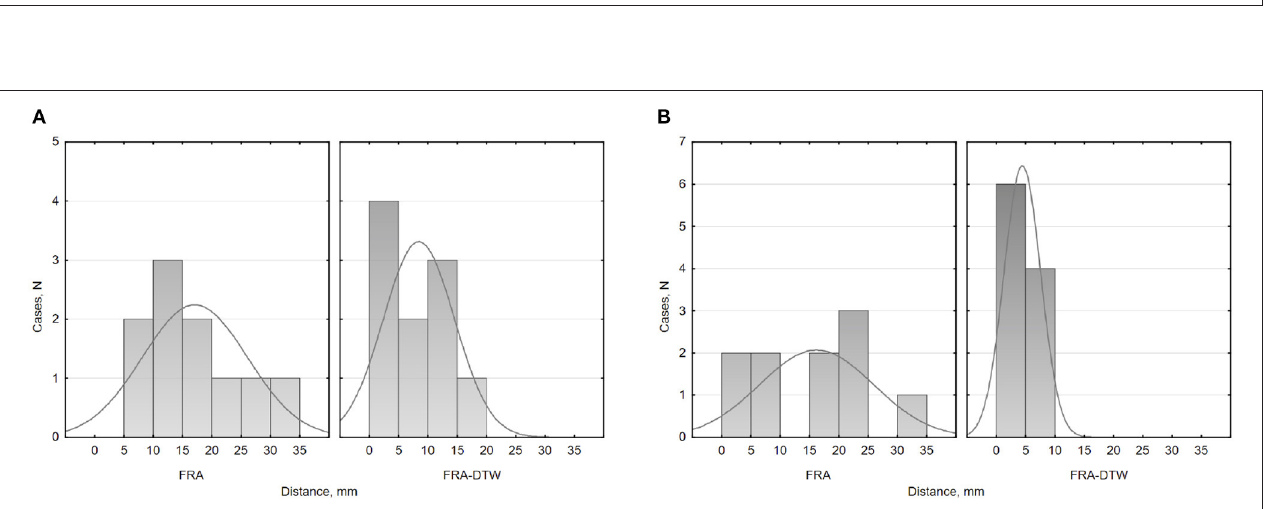
FIGURE 5 | Histograms of LEs for the LV (A) , and RV (B) pacings. The curves represent fitted normal distributions.